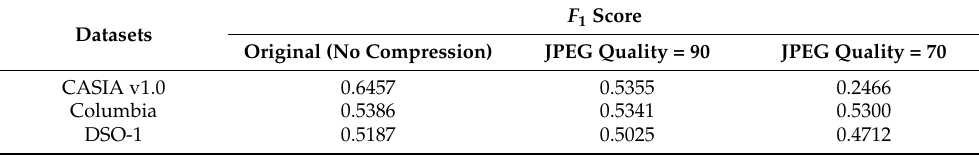
Table 4. The average F 1 scores of our model for JPEG compressed images in the three